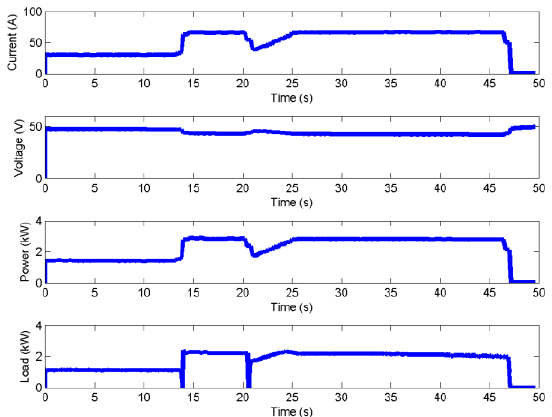
Figure 17. Experimental results for current, voltage, power, and load.